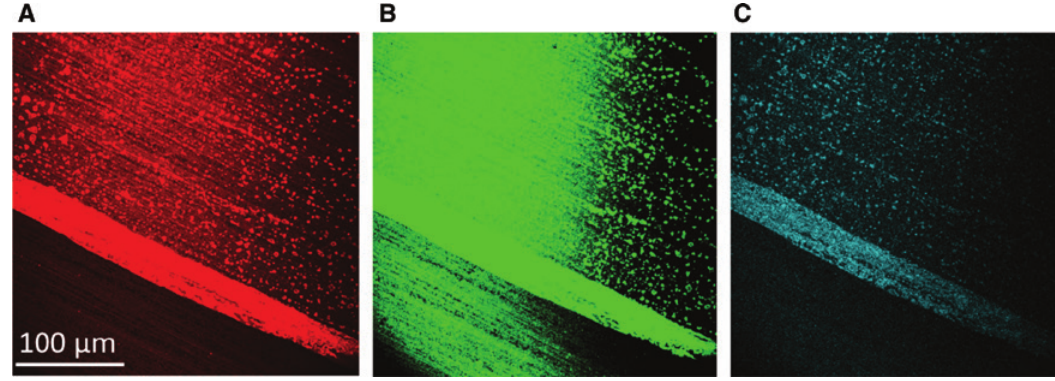
Figure 3: (A) The CARS. (B) The TPEF + SHG. (C) SHG image of graphene at 1360 cm −1 .